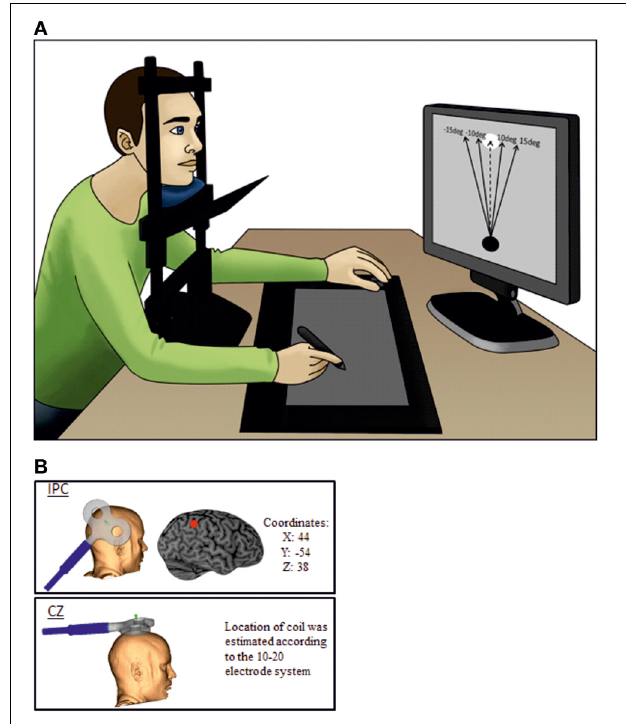
FIGURE 1 | The experimental setup. (A) The subject is not able to see his own arms as vision is blocked. The dotted line is representing the self-controlled movement where subjects have full control of the object and the black lines represent the possible perturbations. During the experiment there were no visible lines or text on the display screen. (B) Illustrate coil orientation and